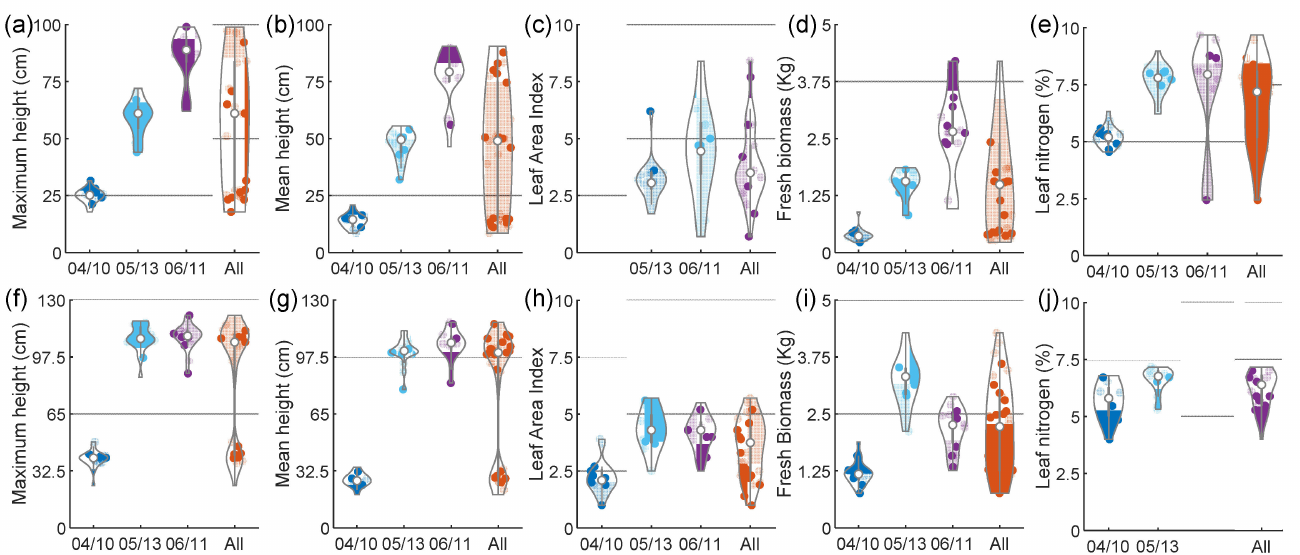
Figure 5. Comparison of measured parameters from wheat and barley crop. Upper row refers to field A and wheat crop ( a – e ), bottom row refers to field G and barley crop ( f – j ). The violin plot demonstrates the maximum, minimum, median (white point), first, and third quartile (start and end of line) values of the plant parameters, and the width of each violin element represents the frequency of the plant